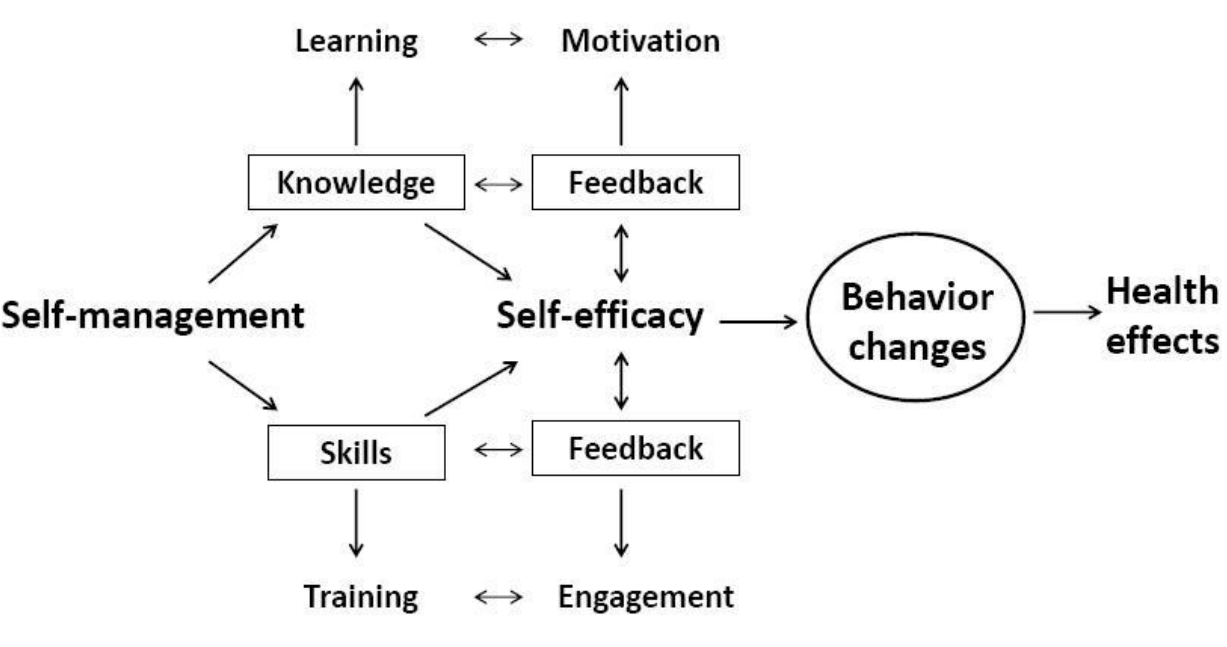
Figure 4. Self-management model adapted from Bourbeau and Nault